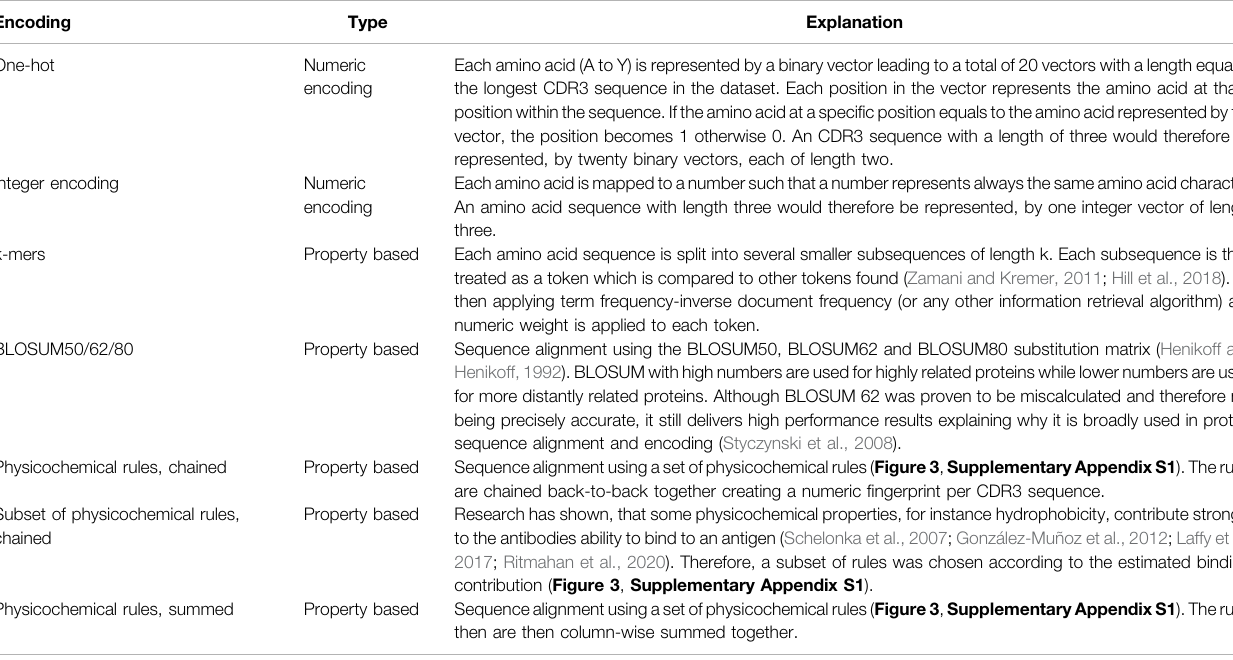
TABLE 1 | Seven encoding methods were benchmarked for their suitability to represent CDR3 a.a. sequences.